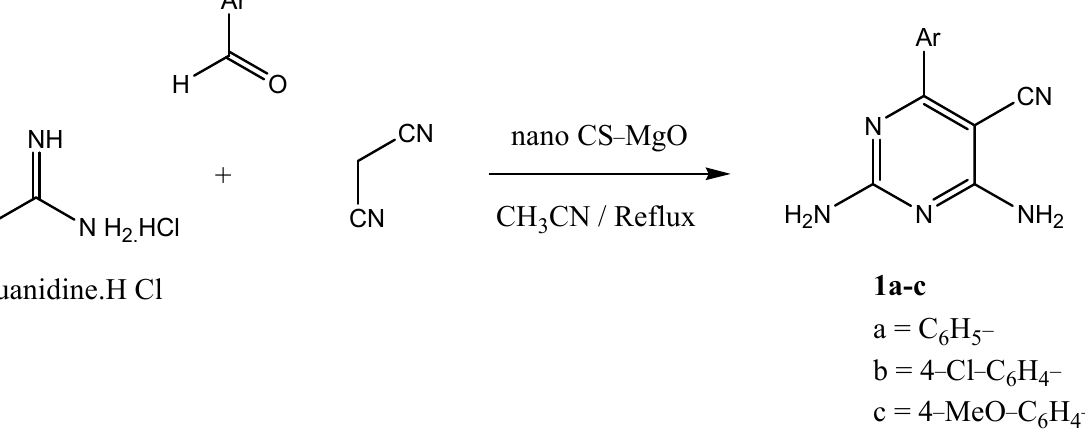
Table 1. Data comparing catalysts and solvent for one pot reaction forming diaminopyrimidine-5-carbonitriles (scheme